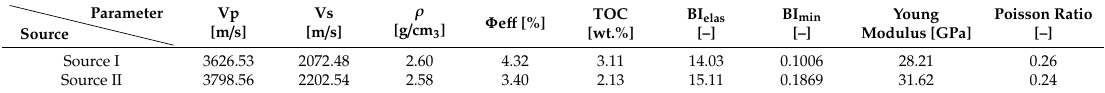
Table 2. Average values of parameters analyzed in the